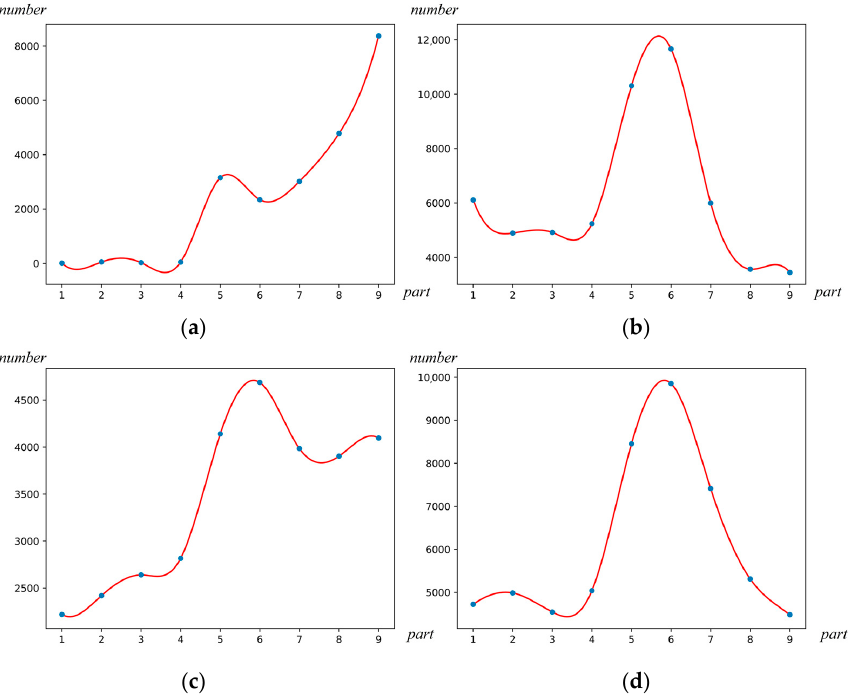
n is the number h a is the left critical h